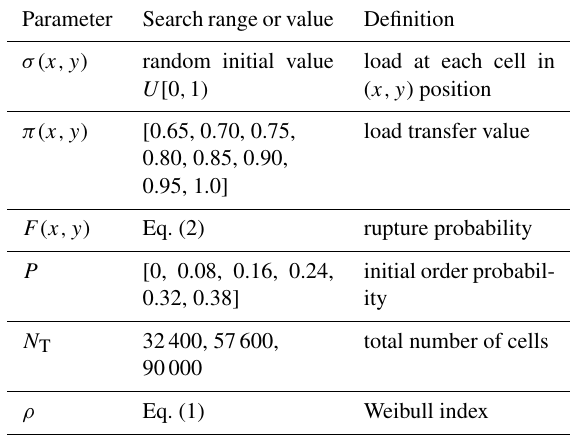
Table 2. Model parameters. Table 3. Statistical parameters of the real catalog of Northridge af- tershocks using different threshold magnitudes ( M min ).